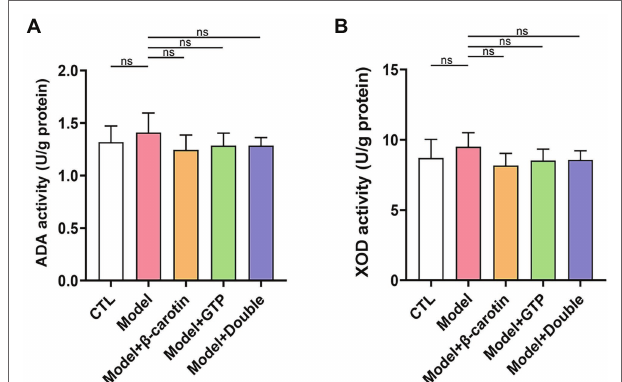
FIGURE 3 | Effects of β -carotin and green tea powder on enzymatic activities related to purine metabolism in mouse hepatic tissue. (A) Level of adenosine deaminase (ADA) activity in the hepatic tissue of five groups of mice based on ELISA. (B) Level of xanthine oxidase (XOD) activity in the hepatic tissue of five groups of mice based on ELISA. “ns” represents no statistical